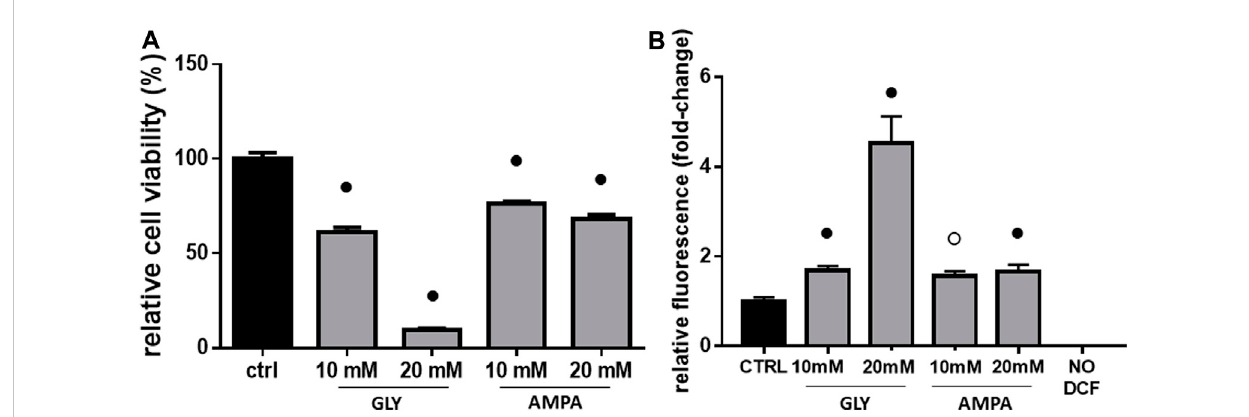
FIGURE 1 Cell viability & ROS production. The fi gure shows the relative histograms obtained from: (A) MTT and (B) DCF-DA assays. H9c2 cells were treated with 10 or 20 mM of glyphosate (GLY) or AMPA for 2 h. After the treatments, cell viability and ROS production were assessed, respectively, through MTT and DCF-DA assays. Mean ± SD; p -values: ○ < 0.0005; C < 0.001 vs . control. NO DCF: control lane without the fl uorescent